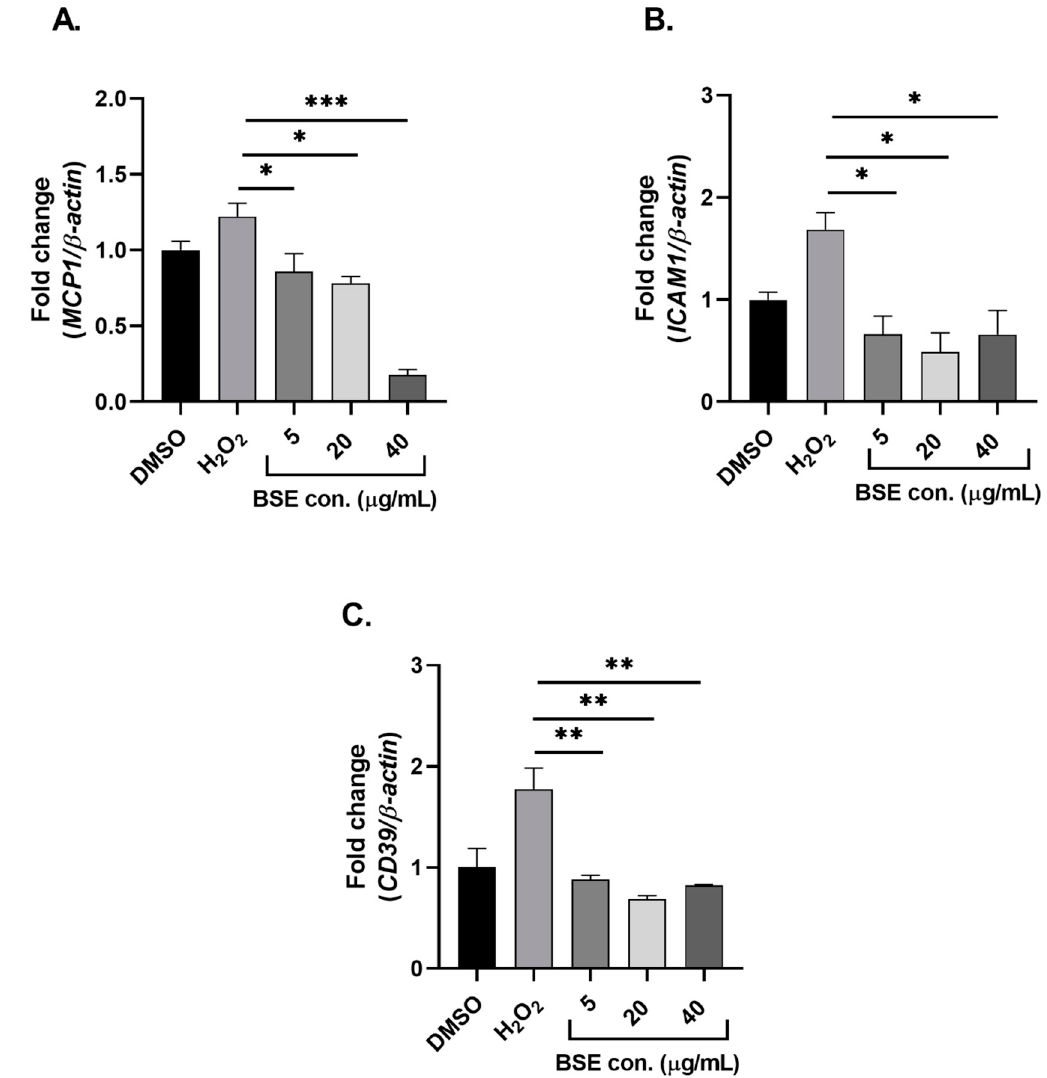
Figure 3. Changes in the gene expression profile of inflammatory mediators [ MCP1 ( A ), ICAM1 ( B ), and CD39 ( C )] with BSE pre-treatment on oxidative stress-induced HUVECs. n = 3. Level of significance indicated as * p < 0.05, ** p < 0.01, *** p < 0.001 one-way ANOVA with Tukey’s multiple comparison post hoc test. Data is presented as mean ± SEM. DMSO—Dimethyl sulfoxide, HUVEC—human umbilical vein endothelial cells, BSE—black sorghum extract.